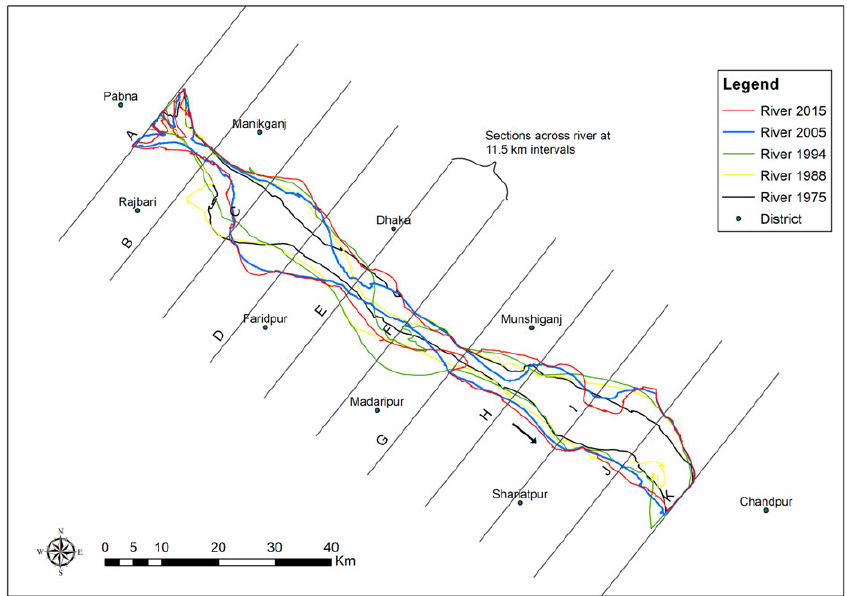
Fig. 5. A schematic diagram of bank line shifting from